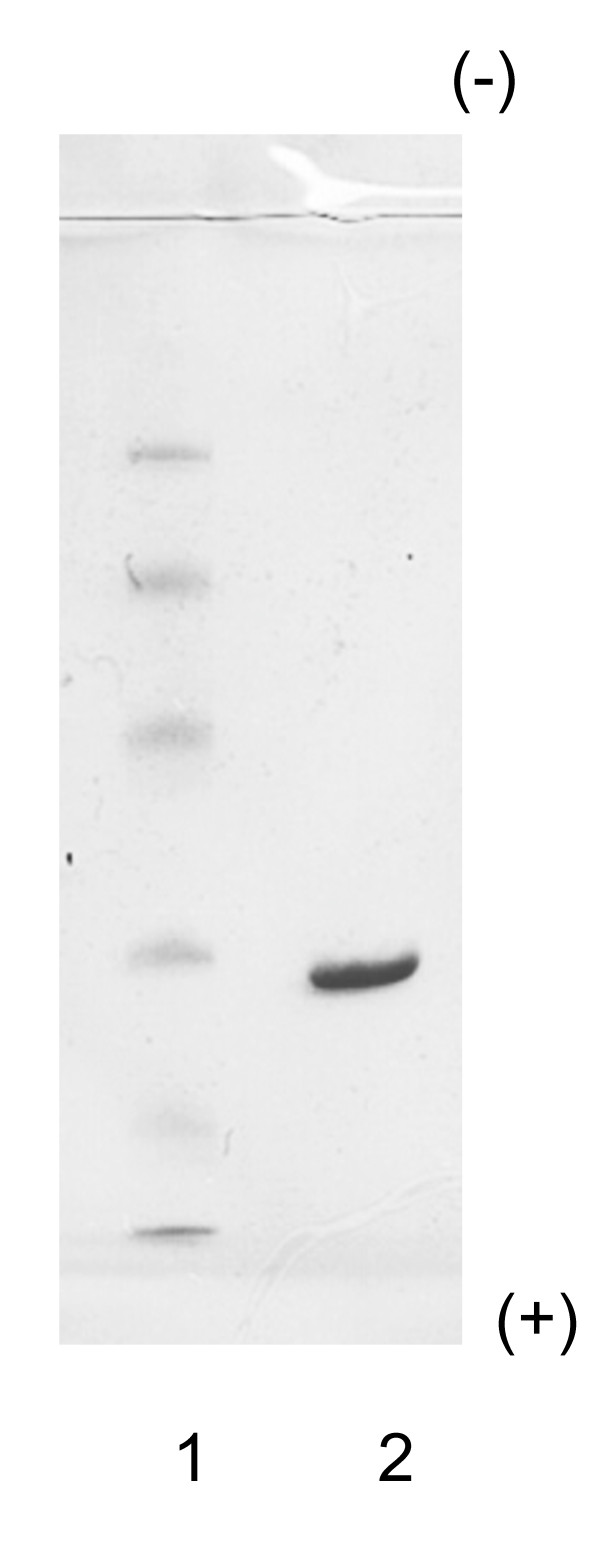
Results of SDS-PAGE of purified chicken CA-III. The 28 kD of purified chicken CA-III was observed. Lane 1, molecular weight marker; lane 2, purified Chicken CA-III. The low molecular weight kit contains phosphorylase (94 kD), albumin (67 kD), ovalbumin (43 kD), CA (30 kD) and trypsin inhibitor (20.1 kD).